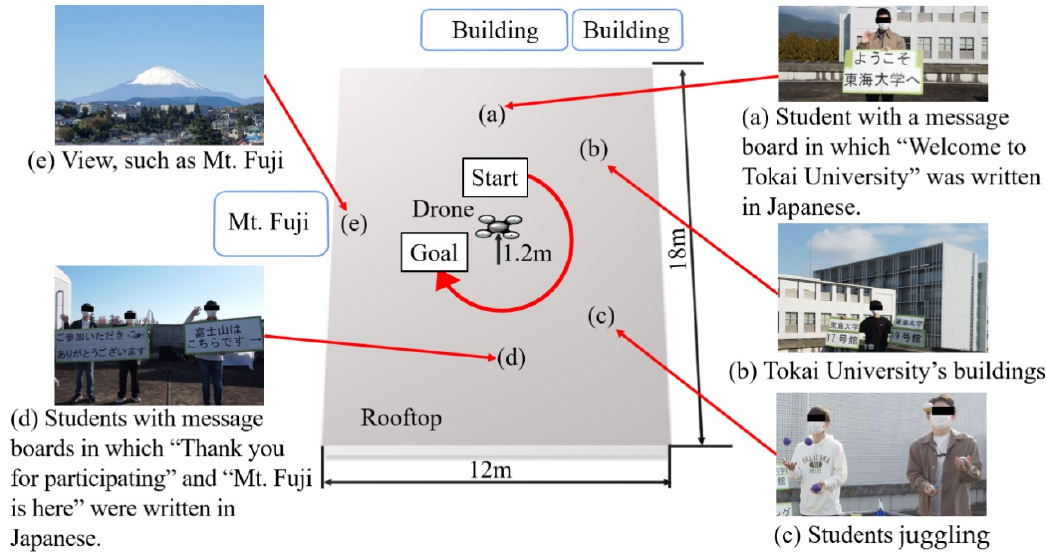
Figure 9. Flight course in the outdoor